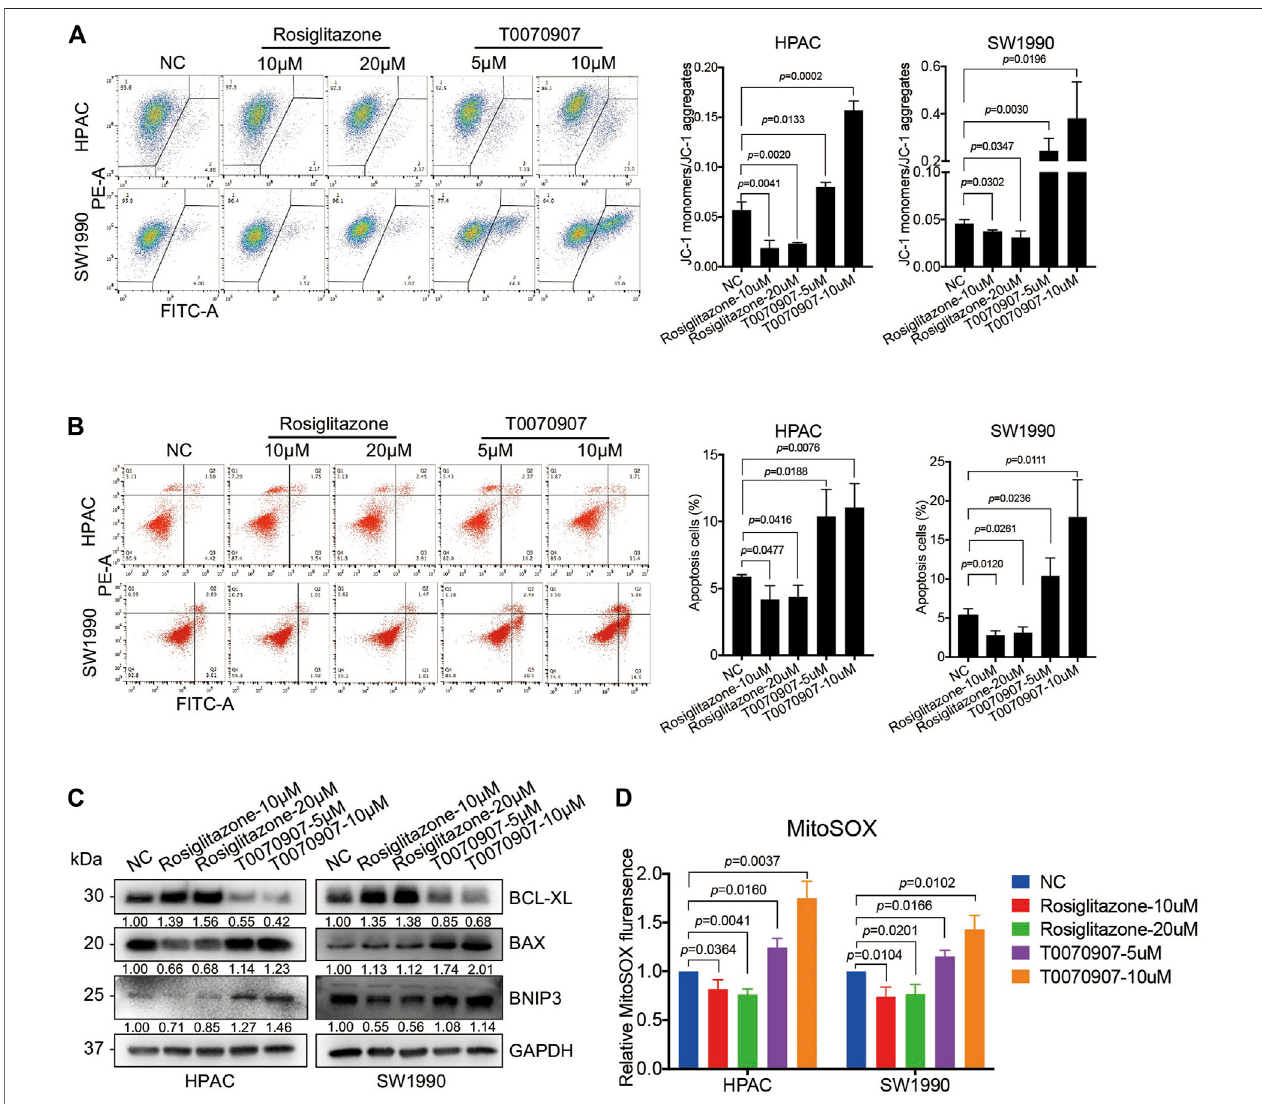
FIGURE 3 | PPAR γ inhibits mitochondrial ROS-dependent apoptosis in pancreatic cancer cells. (A) Treating HPAC or SW1990 cells with negative control, Rosiglitazone (10, 20 μ M) or T0070907 (5, 10 μ M) for 72 h affected mitochondrial membrane potential (MMP) determined by JC-1 fl uorescent intensity. (B) Treating HPAC or SW1990 cells with negative control, Rosiglitazone (10, 20 μ M) or T0070907 (5, 10 μ M) for 72 h affected cell apoptosis determined by fl ow cytometry with Annexin V-FITC/PI staining. (C) The molecular changes in apoptosis determined by Western blot with antibodies against BCL-XL, BAX and BNIP3. (D) Treating HPAC or SW1990 cells with negative control, Rosiglitazone (10, 20 μ M) or T0070907 (5, 10 μ M) for 72 h affected mitochondrial ROS levels determined and quantitated by MitoSOX staining. Experiments were repeated at least three times, with statistical analyses being reported appropriate.